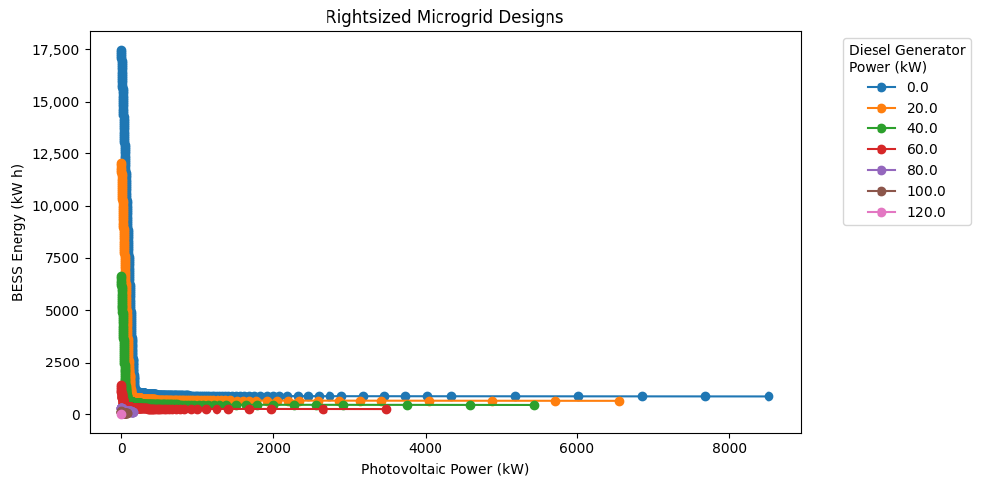
Figure 4. Microgrid designs rightsized to meet power load